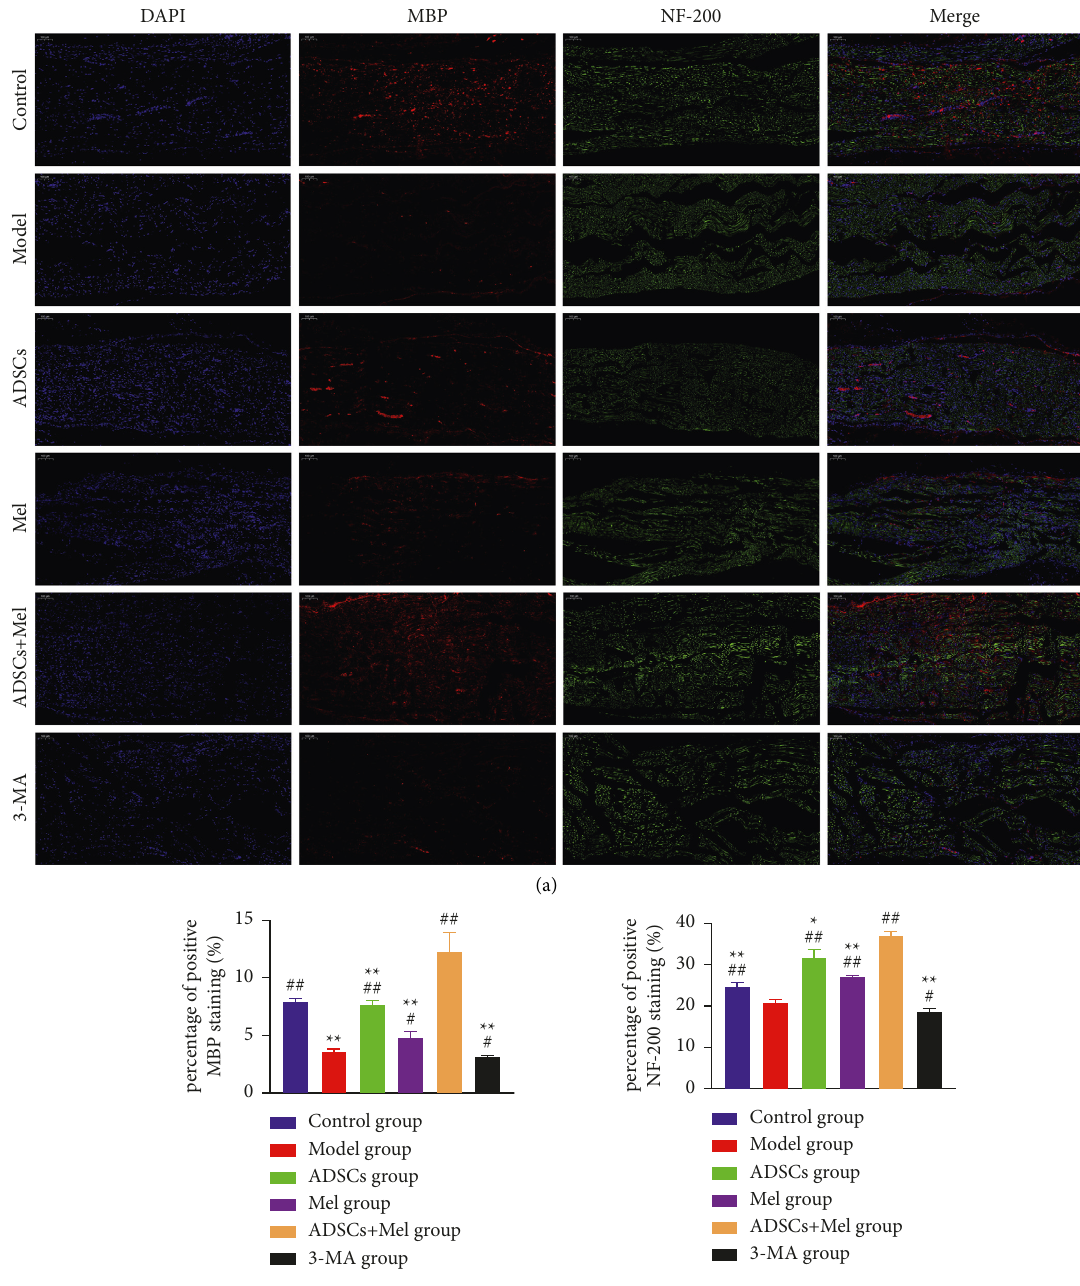
Figure 9: The immunofluorescence intensity expression of MBP and NF-200 was detected by immunocytochemistry. (a) In experimental groups, the fluorescence intensity of MBP (red) and NF-200 (green) elevated, which was detected by immunocytochemistry. (b)-(c) The fluorescence intensity was measured by integrated density pixel. The control group, ADSCs group, Mel group, ADSCs+Mel group, and 3- MA group were compared with the model group, respectively. Each value is the mean ± SE of five independent determinations. ## P < 0 . 01 and # p < 0 . 05, compared with the model group; ∗∗ p < 0 . 05, the control group, ADSCs group, model group, Mel group, ADSCs+Mel group, and 3-MA group were compared with the ADSCs +Mel group; scale bar � 100 μ